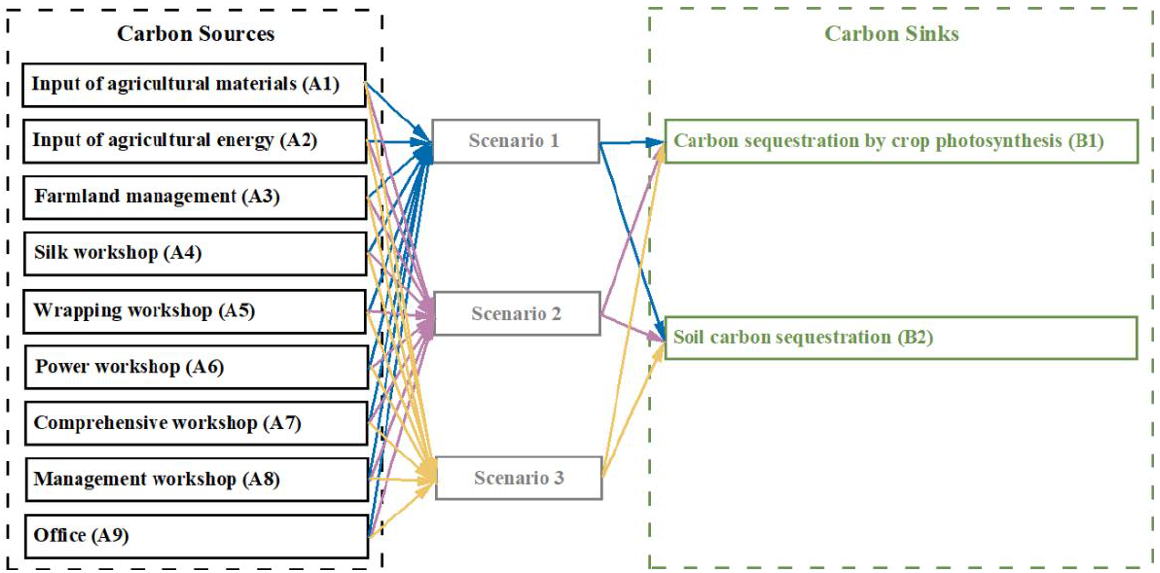
Figure 2. SSM of the tobacco